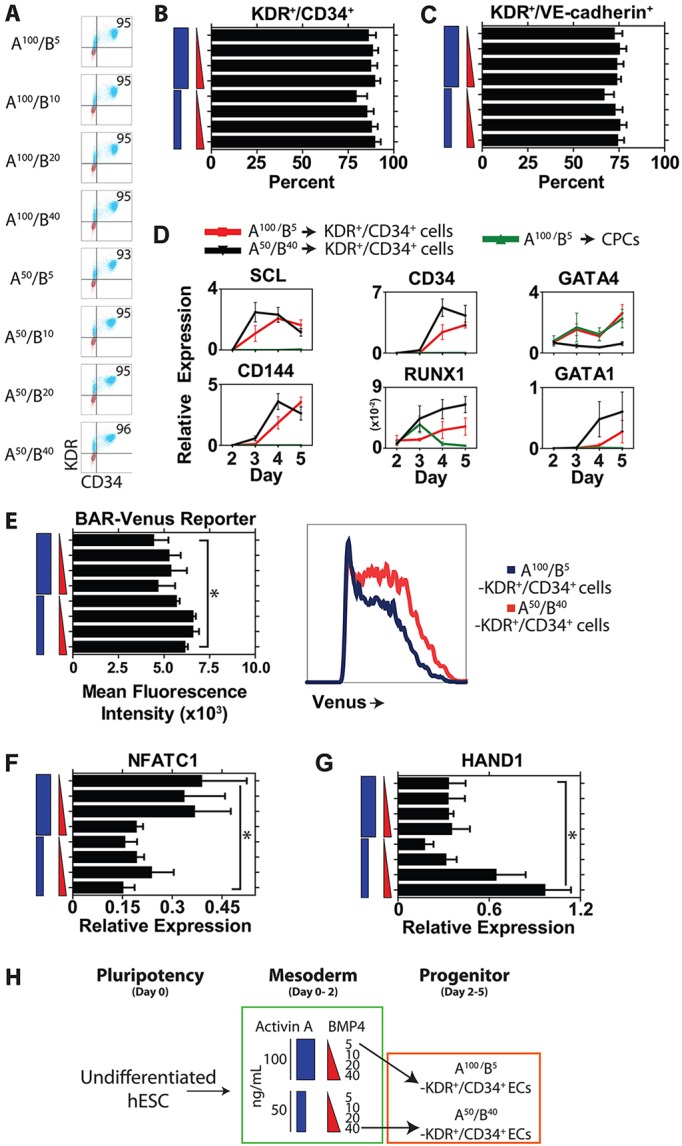
KDR+/CD34+/VE-cadherin+ cells are generated efficiently across doses of activin A and BMP4. (A-C) Flow cytometry plots (A) and mean data for the percentage of cells double positive for KDR and CD34 (B) or for KDR and VE-cadherin (C). (D) qRT-PCR analysis across the timecourse of days 2-5 of differentiation comparing A100/B5-derived CPCs with A100/B5-derived KDR+/CD34+ cells and A50/B40-derived KDR+/CD34+ cells. CD144 refers to VE-cadherin. (E) Wnt/β-catenin signaling activity as measured by the BAR-Venus reporter in day 5 KDR+/CD34+ cells under different doses of activin A and BMP4 (left), with representative raw flow cytometry plot of Venus activity in A100/B5 KDR+/CD34+ versus A50/B40 KDR+/CD34+ cells (right). (F,G) qRT-PCR analysis for markers of endothelium including NFATC1 (F) and HAND1 (G). (H) Schematic showing lineage differentiation for directing undifferentiated hESCs into A100/B5-derived KDR+/CD34+ cells and A50/B40-derived KDR+/CD34+ cells. n=3-8 replicates per sample for all assays. *P<0.05.